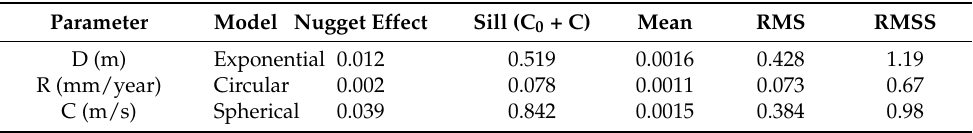
RMS: Root mean square, RMSS: Root mean square